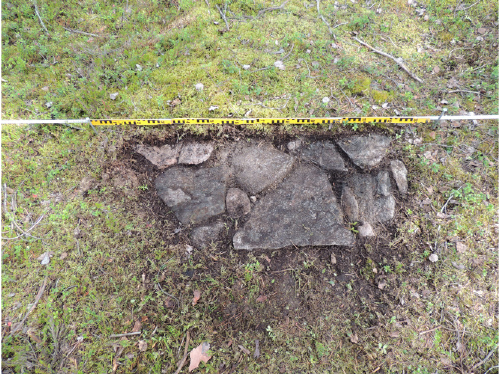
Figure 7. Rounded hearth with a packing of flat stones, from area 2 NHB 564. Bones in the hearth are dated to the period AD 1670-1940. Artifacts con- nected to the site suggest the latter part of the 19 th century.